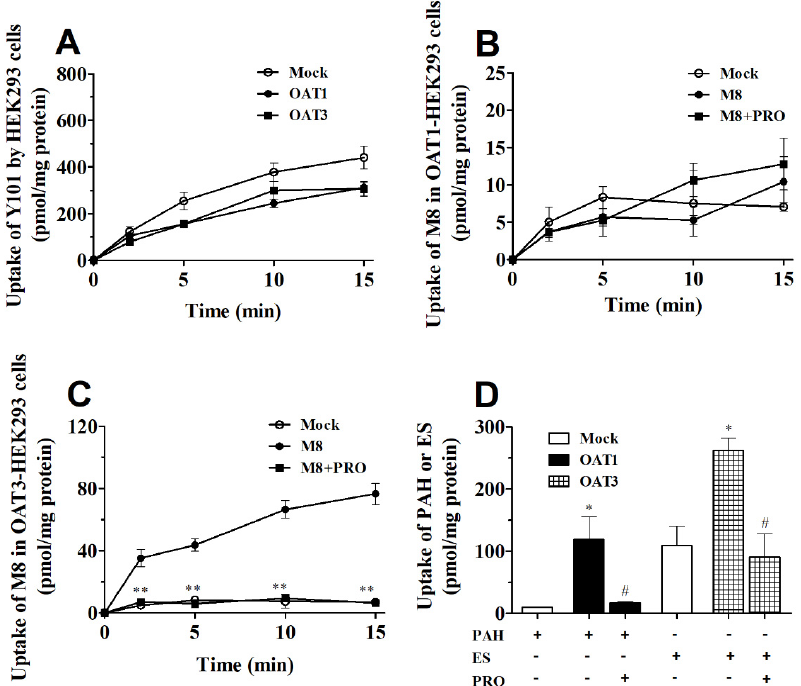
Figure 9. Uptake of Y101, M8, PAH and ES in OAT1/3-HEK293 cells. ( A ): uptake of Y101 (2.0 µM) in mock, hOAT1 and hOAT3-HEK293 cells; ( B ): uptake of M8 (10 µM) in mock and hOAT1-HEK293 cells in the absence or presence of PRO; ( C ): uptake of M8 (10 µM) in mock and hOAT3-HEK293 cells in the absence or presence of PRO (**, p ˂ 0.01 vs. M8 alone); ( D ): uptake of PAH (10 µM) and ES (10 µM) with or without PRO (100 µM) for 10 min (*, p ˂ 0.05 vs. mock cells; # , p ˂ 0.05 vs. without-PRO group). Data are expressed as mean ± SD, n = 3.